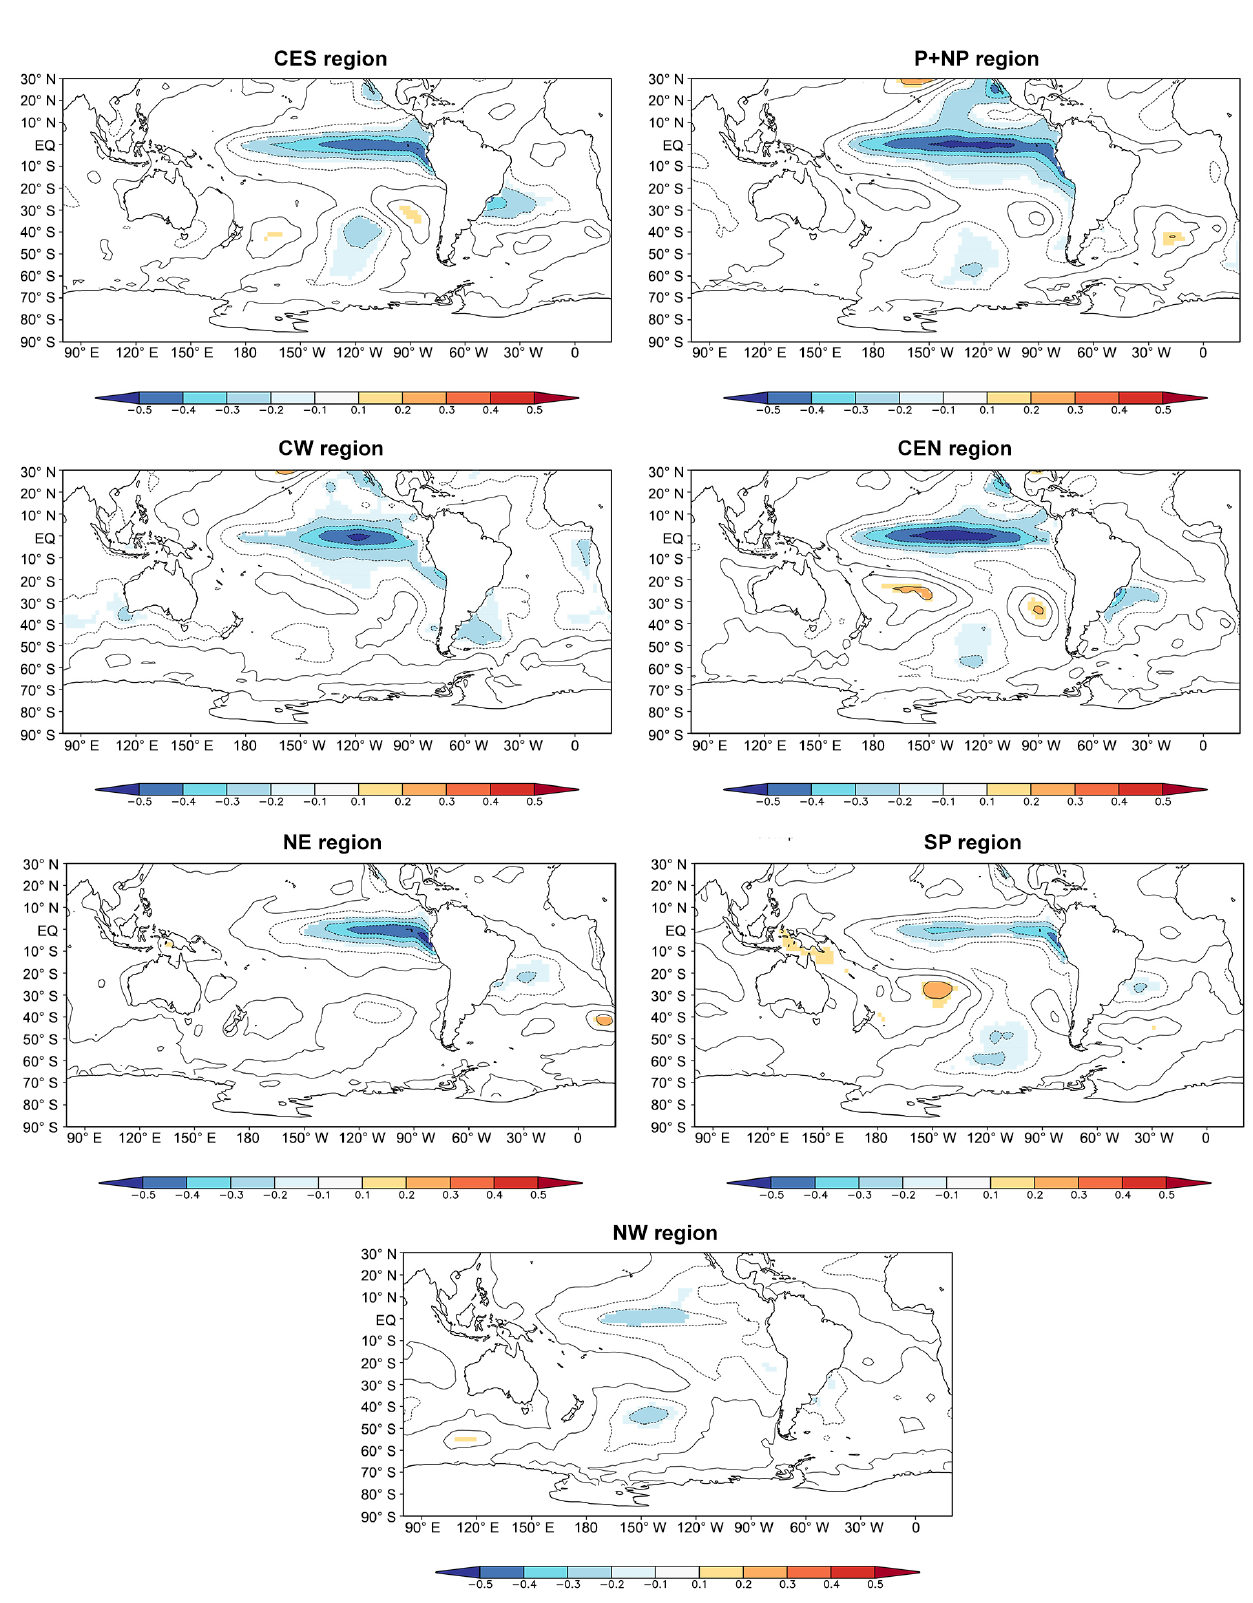
Figure 7. Composites of SST anomalies during the months with drought conditions for each of the seven regional SPI3 patterns. Shaded areas are significant at the 95%